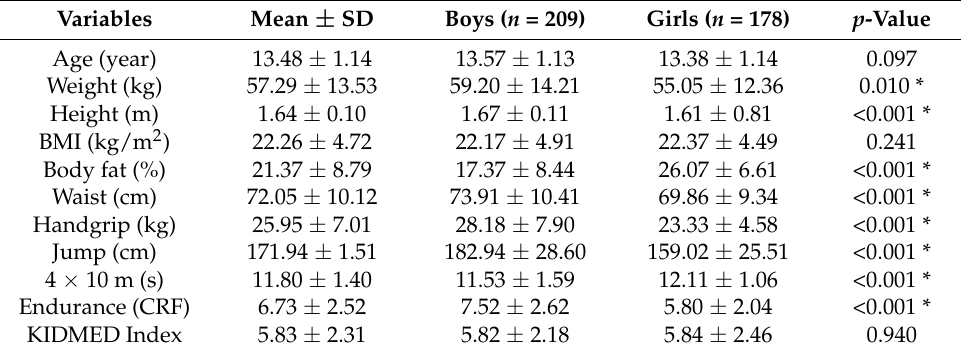
Table 1. Anthropometric characteristics and physical fitness variables ( n = 387).